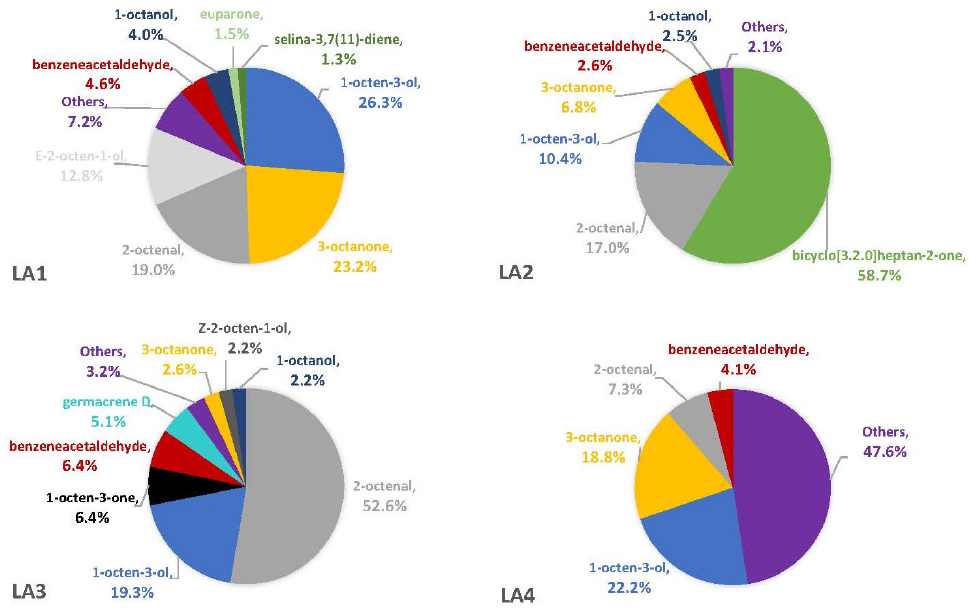
Figure 3. Average percentages (over three replicates) of VOCs contributing to total headspace profile of each Aspergillus strain while growing on CZ medium.